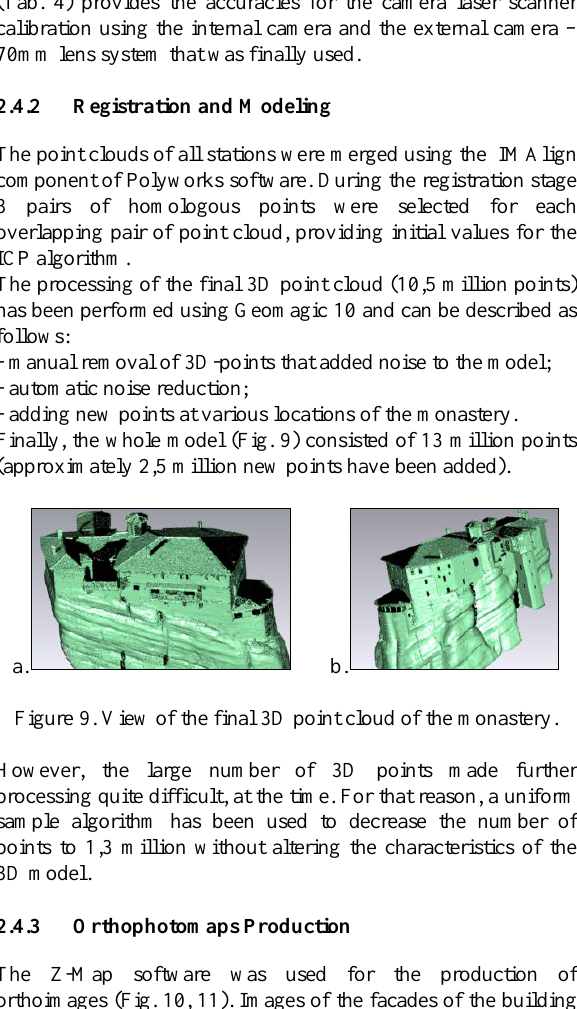
Figure 6. Selecting homologous points for station B.